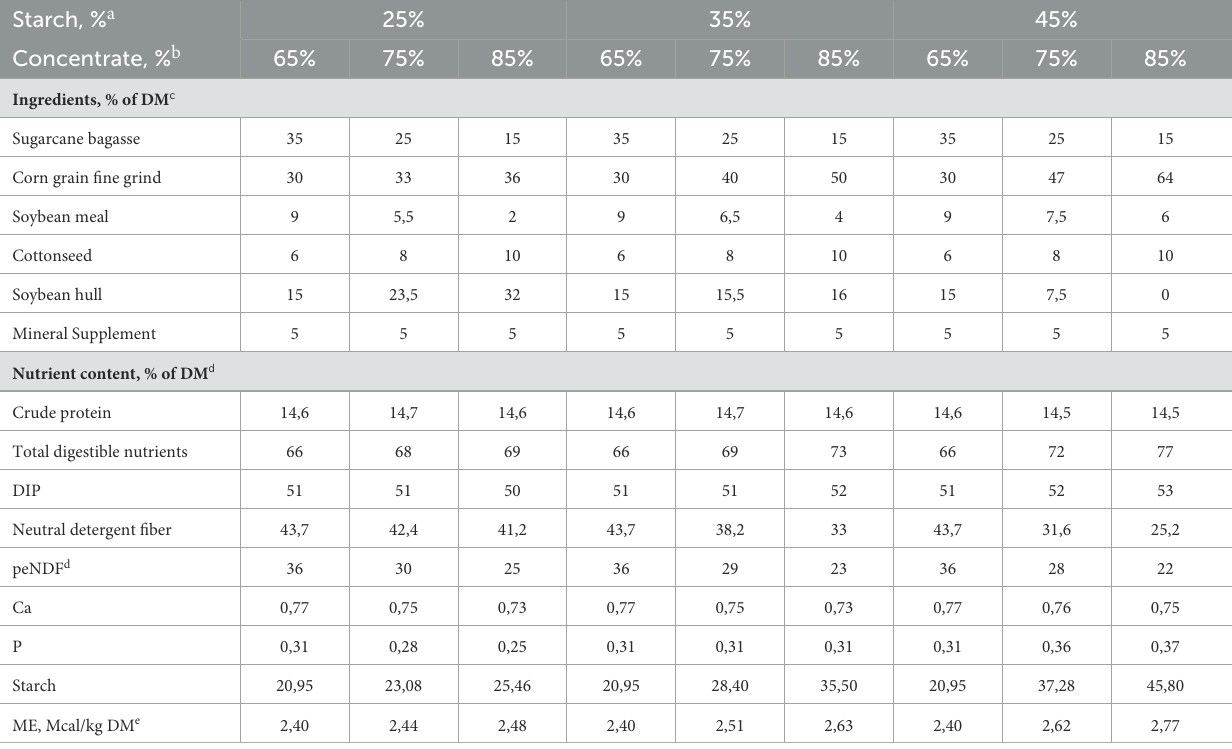
TABLE 1 Feed ingredients and chemical composition of diets containing levels of starch fed to Nellore yearling bulls supplemented with essential oils and amylase or sodium monensin. Starch, % a 25% 35% 45% Concentrate, % b 65%